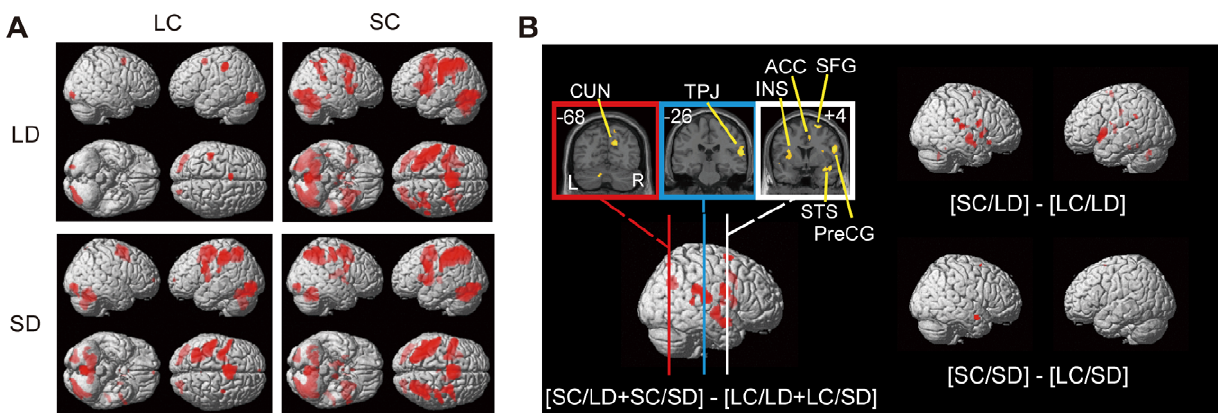
Figure 3. Brain areas activated under each condition. (A) Red areas showed greater activation in the task than in the rest period. LC: the larger digit choice; SC: the smaller digit choice; LD: Large distance; SD: Small distance. The threshold p -value under each condition was 0.001 (uncorrected). (B) Comparison between the brain areas that were activated under the SC and LC conditions with p -values lower than 0.001 (uncorrected). The number at the upper left of the picture in each section indicates the y -level on the MNI coordinates. (CUN: cuneus/precuneus, TPJ: temporo–parietal junction, INS: insula, ACC: anterior cingulate cortex, SFG: superior frontal gyrus, STS: superior temporal sulcus, PreCG: precentral gyrus).